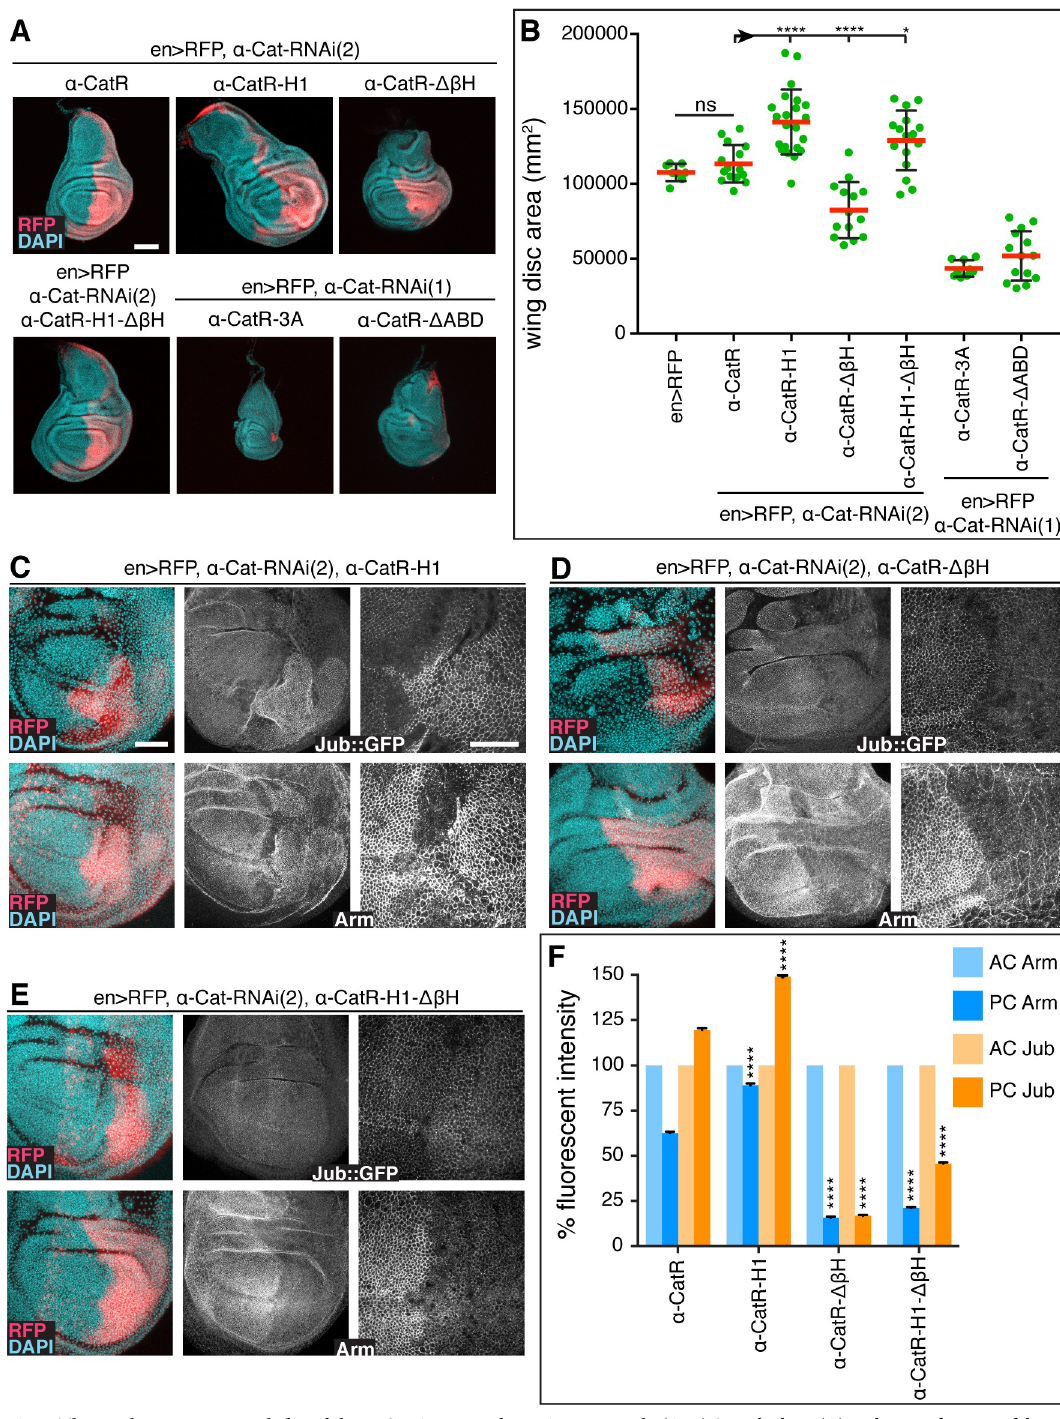
Fig 8. The mechanosensory α 1-helix of the α -Cat ABD regulates tissue growth. (A, B) Sample discs (A) and quantification of disc area (B) of late 3 rd larval instar wing discs of the indicated genotypes. Note that UAS- α -CatR-H1 expression in en-Gal4 , UAS- α -Cat- RNAi(2) discs causes hyperplastic overgrowth. α -CatR-3A and α -CatR- Δ ABD expression enhanced the phenotype of en > α -Cat-RNAi (1) discs. 3 rd larval discs expressing α -CatR-3A in a en > α -Cat-RNAi(2) background did not develop. Two-tailed, unpaired t-test; ���� (P � 0.0001), � (P = 0.0148), ns (P > 0.05). Scale bars, 100 μ m. (C-E) Late 3 rd larval instar discs expressing en-Gal4 , UAS-RFP , UAS- α -Cat-RNAi(2) and either UAS- α -CatR-H1 (C), UAS- α -Cat- Δβ H (D), or UAS- α -CatR-H1- Δβ H (E). Discs express Jub::GFP controlled by its endogenous promoter (upper panels) and are stained for Arm (lower panels). Nuclei are labeled with DAPI. Close-up images to